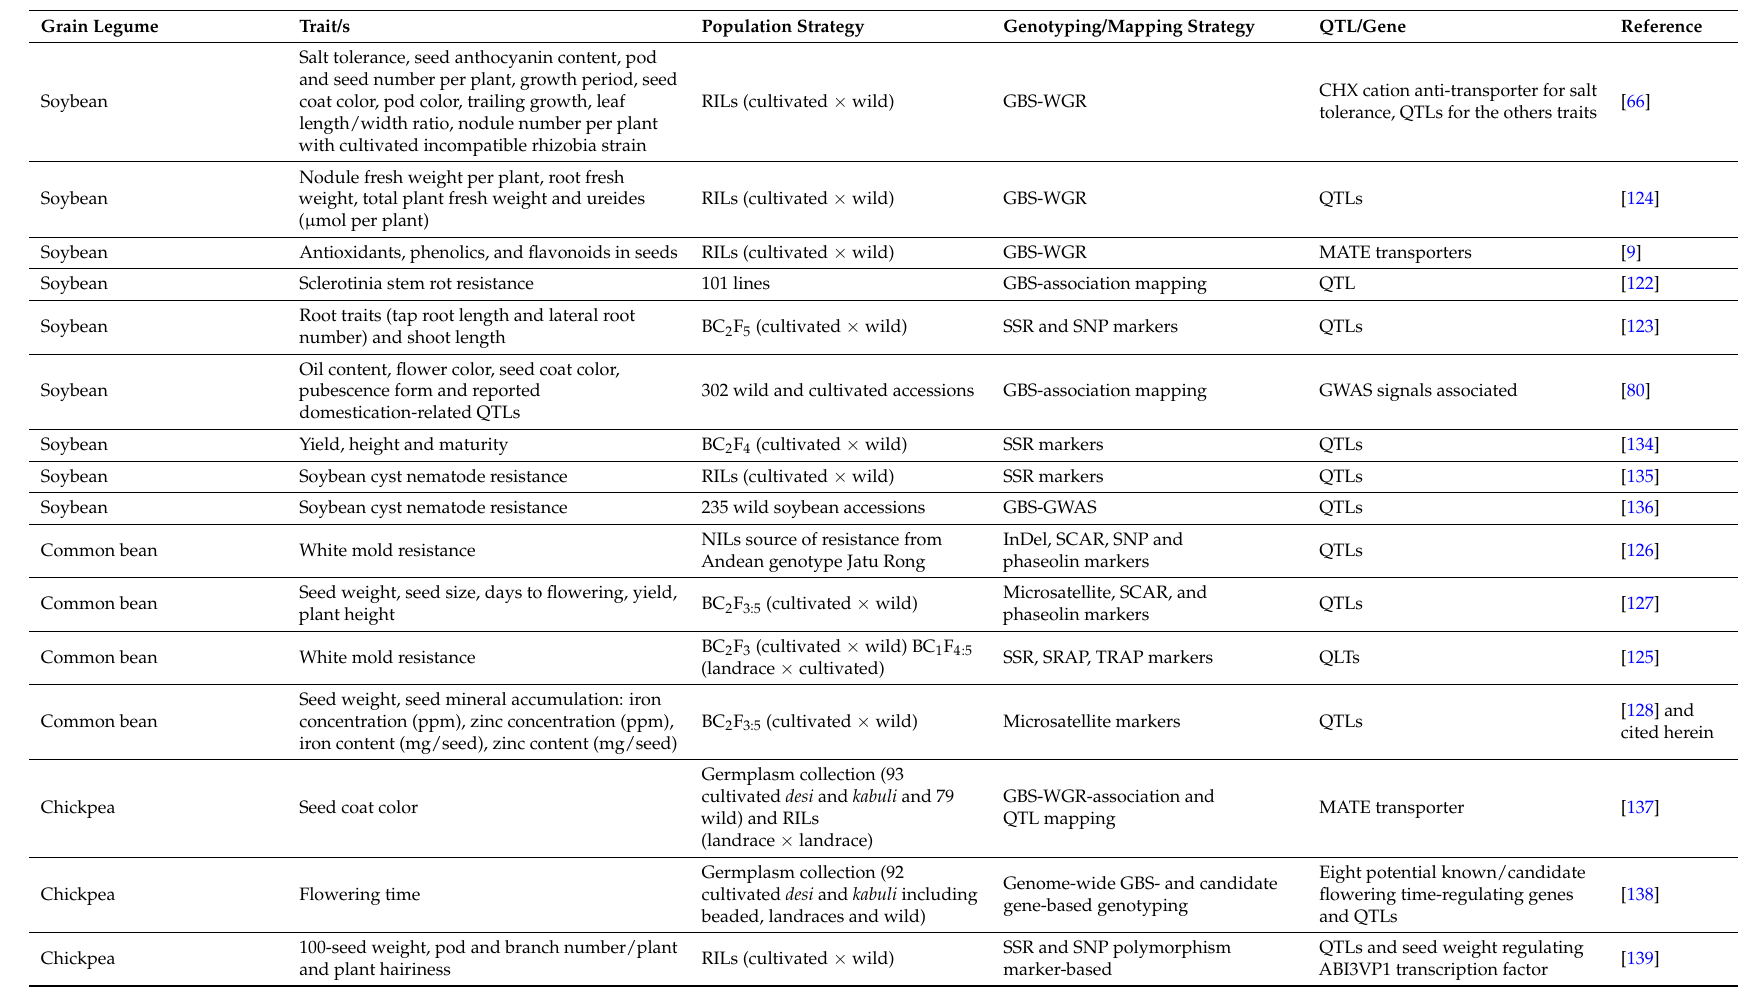
Table 2. Trait-related QTLs/genes in grain legumes characterized using wild